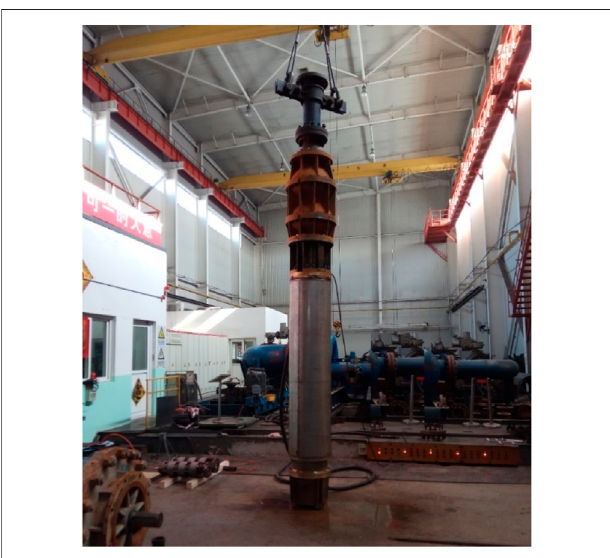
FIGURE 11 | Two-stage lifting pump on the test